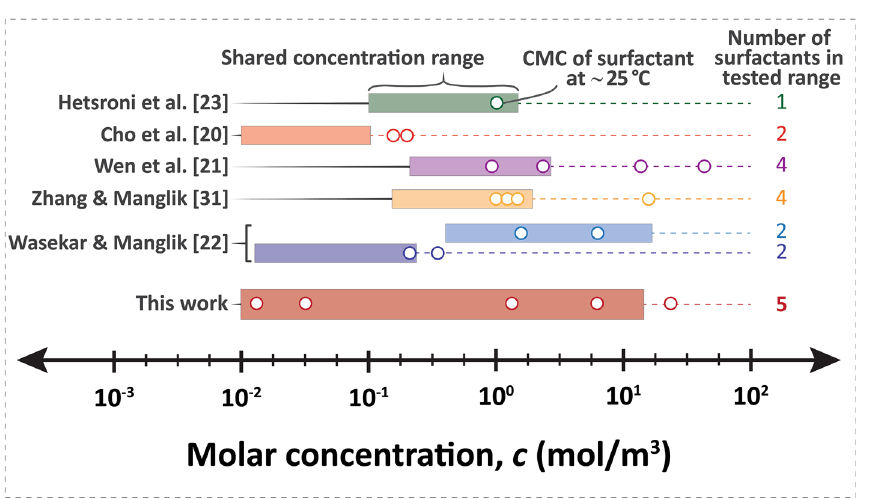
Figure 2. Our work encompasses more surfactants, a larger shared concentration range inclusive of all tested surfactants (rectangles), and a larger CMC range (circles) in comparison to previous